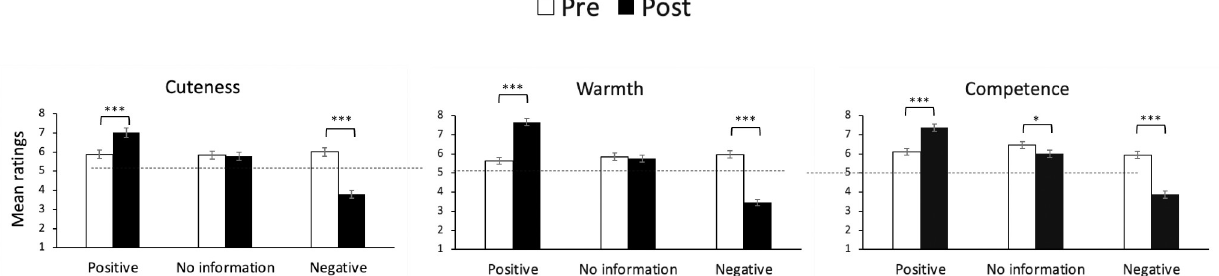
Fig 2. Cuteness, warmth, and competence ratings before/after personality manipulation (Study 1). Error bars indicate standard error. The dotted lines indicate the midpoints. � p < .05, ��� p <